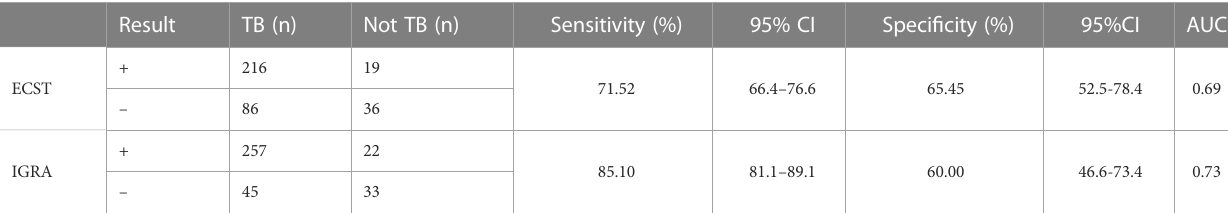
TABLE 3 Comparison of the accuracy of the ECST and IGRA tests in patients with clinically diagnosed